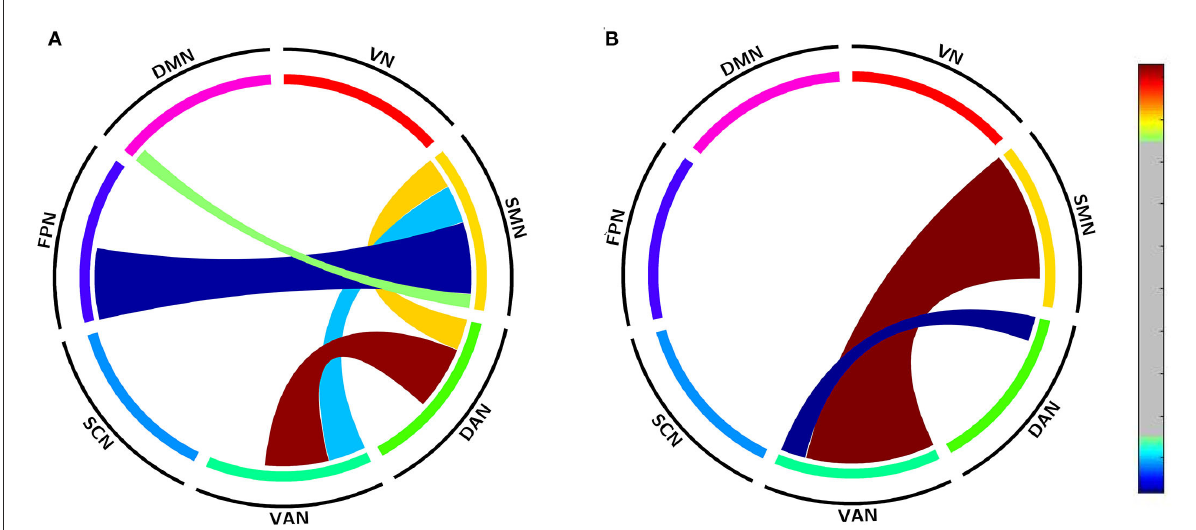
FIGURE5 Altered large-scale network functional connectivity. (A) Altered large-scale network functional connectivity between SD and RW state; (B) Altered large-scale network functional connectivity for SD between after and before acupuncture. For the T -value color bar, blue indicates functional connectivity decrease while red indicates functional connectivity increase. The result was corrected by FDR-corrected p < 0.05 (two-tailed). DAN, dorsal attention network; DMN, default mode network; FC, functional connectivity; FPN, frontoparietal network; L, left; R, right; SCN, subcortical network; SMN, somatosensory network; VAN, ventral attention network; VN, visual network; RW, rested wakefulness; SD, sleep